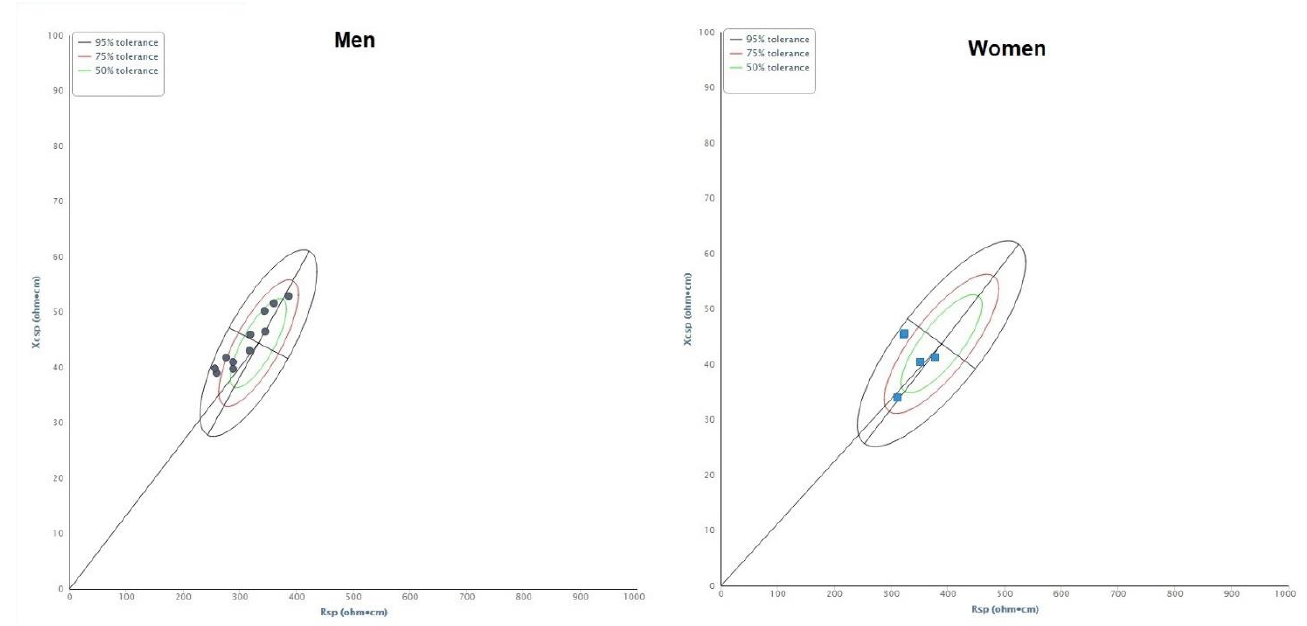
Figure 1. Distribution of bioelectrical vectors of athletes on the sex-specific tolerance ellipses. Vectors falling towards the upper pole indicate a tendency toward higher %FM, while those on the right side indicate a tendency toward greater cellular mass and ICW/ECW. Black dots: men; blue dots: women. Rsp: specific resistance; Xcsp: specific reactance.